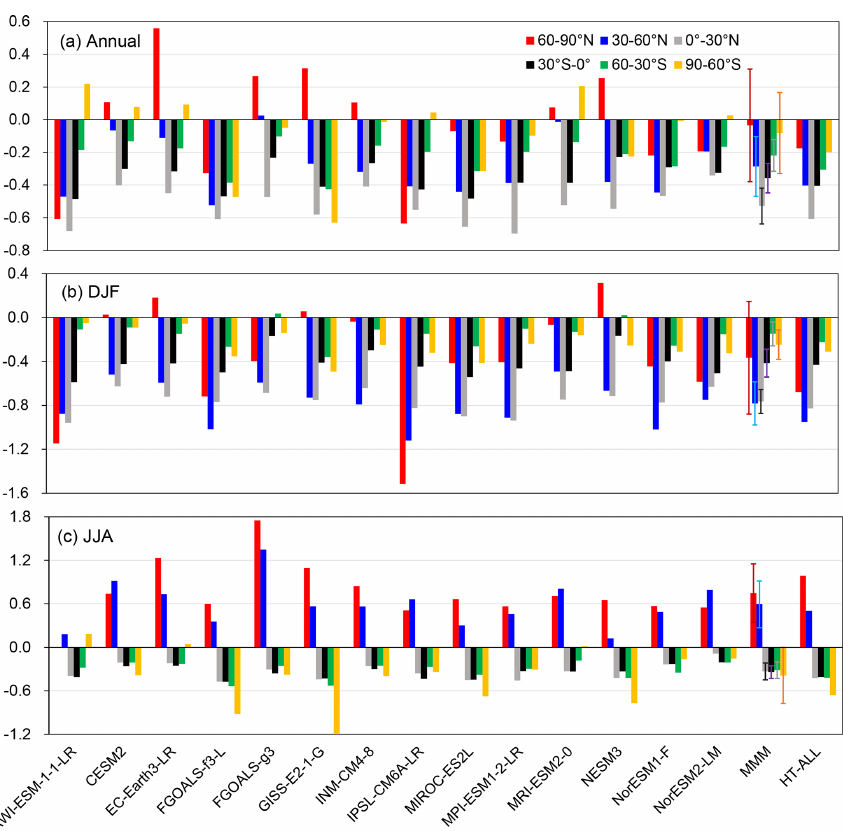
Figure 7. Zonal averaged changes in (a) annual, (b) DJF, and (c) JJA mean surface air temperatures (units in ◦ C) between the Middle Holocene and preindustrial simulations in the 14 PMIP4 models and their arithmetic mean (MMM), as well as between the averages for 6ka ± 0.05ka and the last 101 years (i.e., 1750–1850) in the HT-ALL simulation. Red, blue, gray, black, green, and orange bars represent the changes averaged over the zonal bands of 60–90 ◦ N, 30–60 ◦ N, 0 ◦ –30 ◦ N, 30 ◦ S–0 ◦ , 60–30 ◦ S, and 90–60 ◦ S, respectively. The error bar for the multimodel mean change represents plus and minus 1 standard deviation for the 14 PMIP4